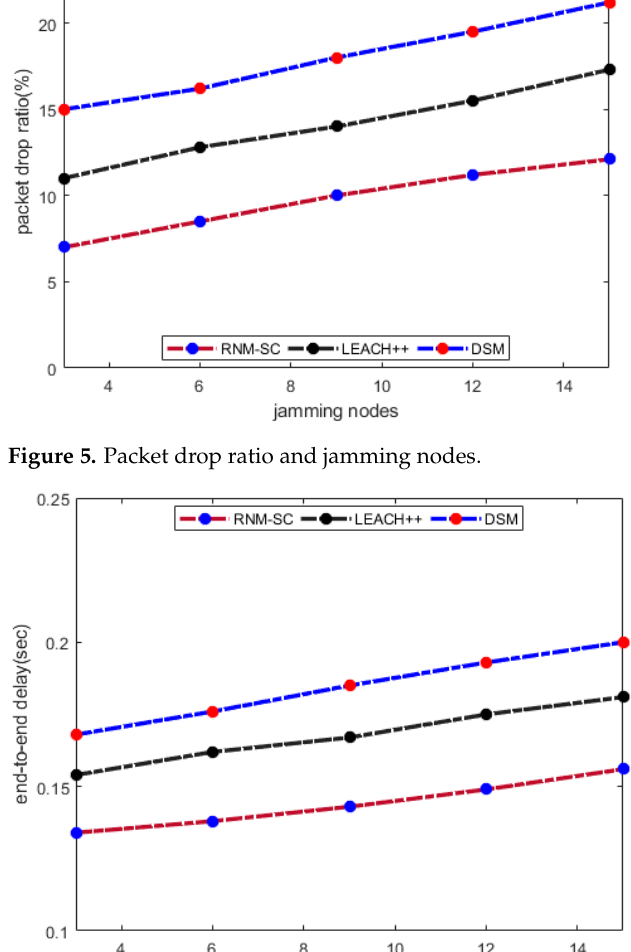
Figure 6. End-to-end delay and jamming